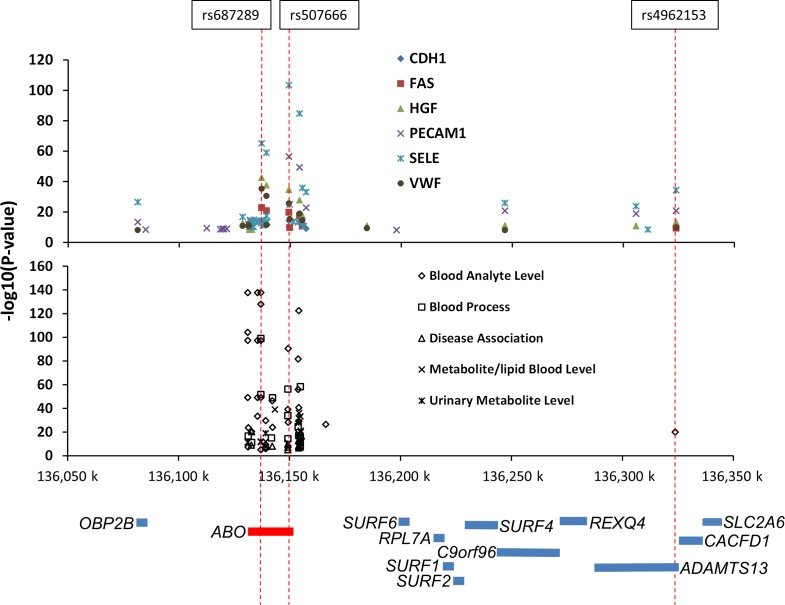
SNPs in ABO are the strongly associated with many blood biomarker levels as well as other non-blood analyte measurements.Trans pQTLs in the ABO region (shown in schematic form below the plots) were common in this study (top panel) and in published studies (GWAS Catalog). The rs687289 or rs507666 SNPs in the ABO blood group locus on chromosome 9, which encodes alpha 1-3-N-acetylgalactosaminyltransferase, are a major determinant of ABO blood type. In this study, these SNPs were the strongest pQTLs for 6 blood biomarkers, all distant (trans) from their biomarker genes. Other biologic features (such as clotting time), metabolites (proteins, lipids, hormones), and urinary features have been noted to have strong association with this locus (see [10, 35–73]).